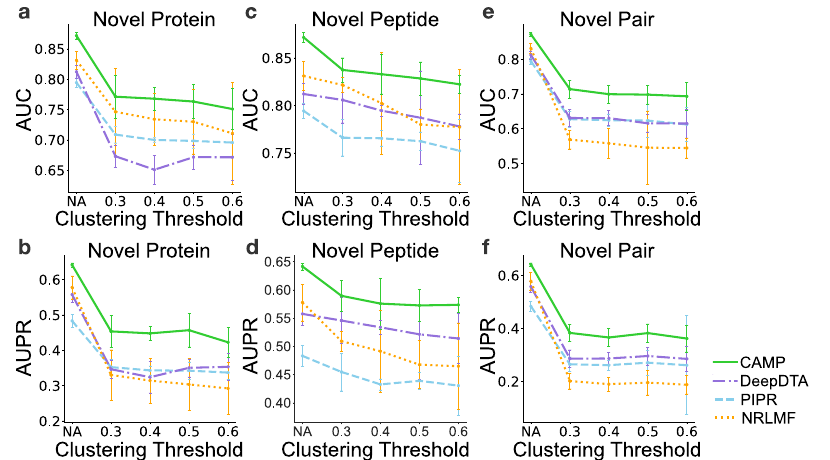
Fig. 2 AUC and AUPR of CAMP and baseline models through cross-validation under three settings. a , b show the AUC and AUPR of CAMP and other baseline methods under the “ novel protein setting ” , respectively. c , d show the AUC and AUPR of CAMP and other baseline methods under the “ novel peptide setting ” , respectively. e , f show the AUC and AUPR of CAMP and other baseline methods under the “ novel pair setting ” , respectively. The error bars under “ novel protein setting ” and “ novel peptide setting ” represent the mean ± standard deviation over fi ve folds ( n = 5). The error bars under “ novel pair setting ” represent the mean ± standard deviation over nine folds ( n = 9). “ NA ” stands for random cross-validation, i.e., randomly splitting the data set and used 80% of the data set to train the model and the remaining 20% to evaluate the